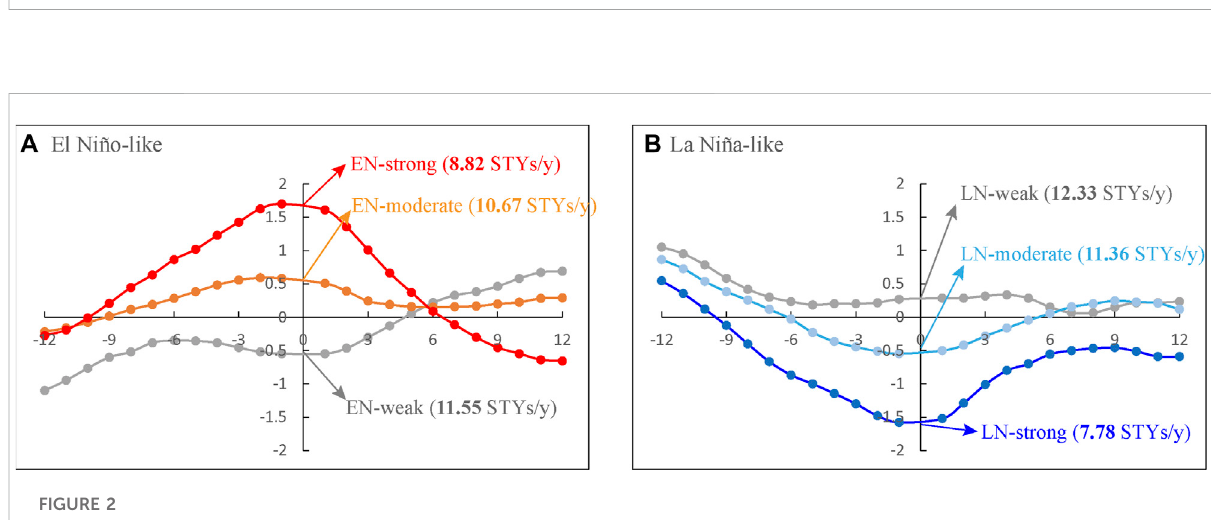
ONI curves for the previous and current years and the number of STYs corresponding to the current year. (A) Curves for the “ EN-weak, ” “ EN- moderate, ” and “ EN-strong ” divisions of the El Niño-like category. (B) Curves for the “ LN-weak, ” “ LN-moderate, ” and “ LN-strong ” divisions of the La Niña-like